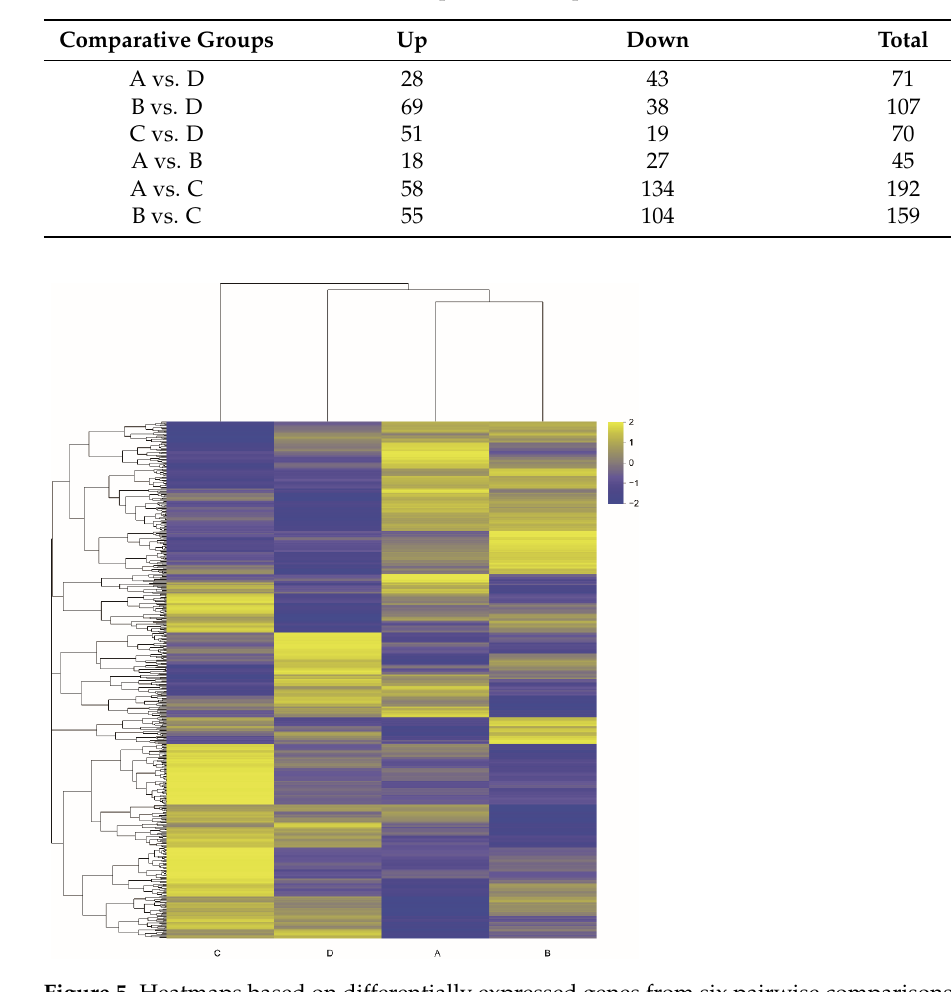
Table 2. The number of DEGs in the six pairwise comparisons.